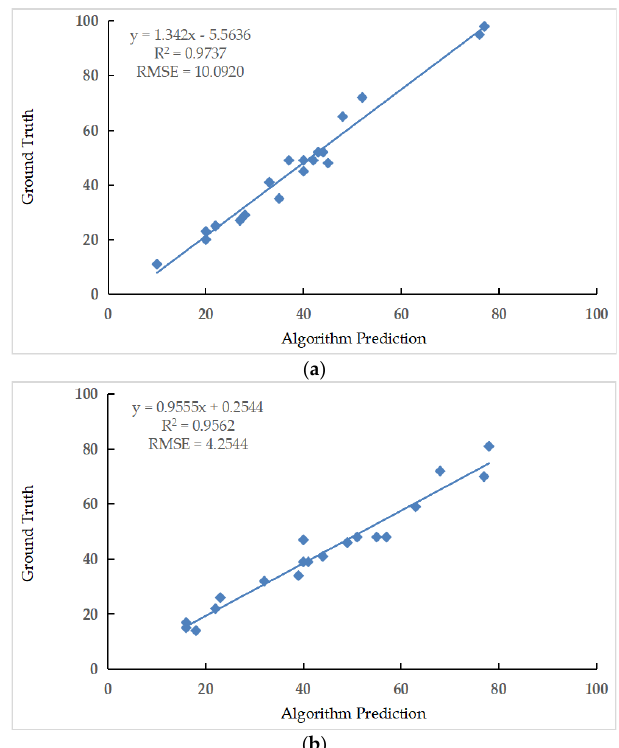
Figure 14. Performance evaluation of fruit yield estimation. ( a ) Evaluation results of the apple yield estimation. ( b ) Evaluation results of the orange yield